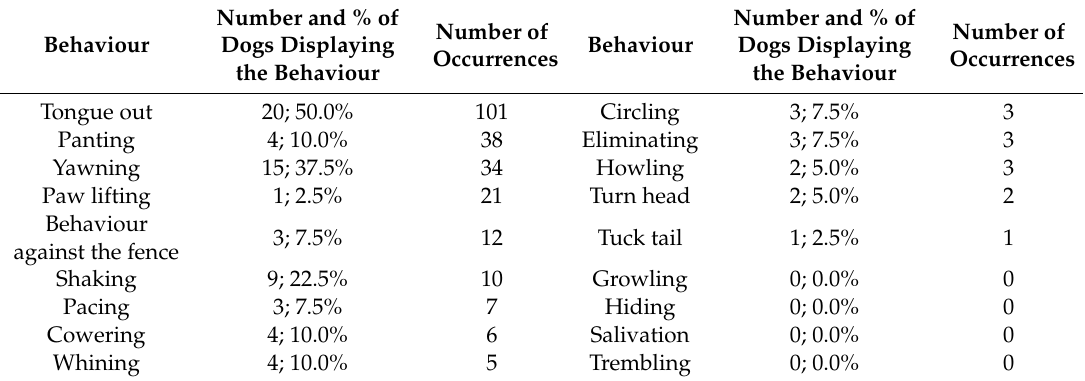
Table 1. Number of dogs and relative percentage (%, calculated on the total sample of 40 dogs) displaying each of the 18 stress-related behaviours, and number of occurrences (times the behaviour was